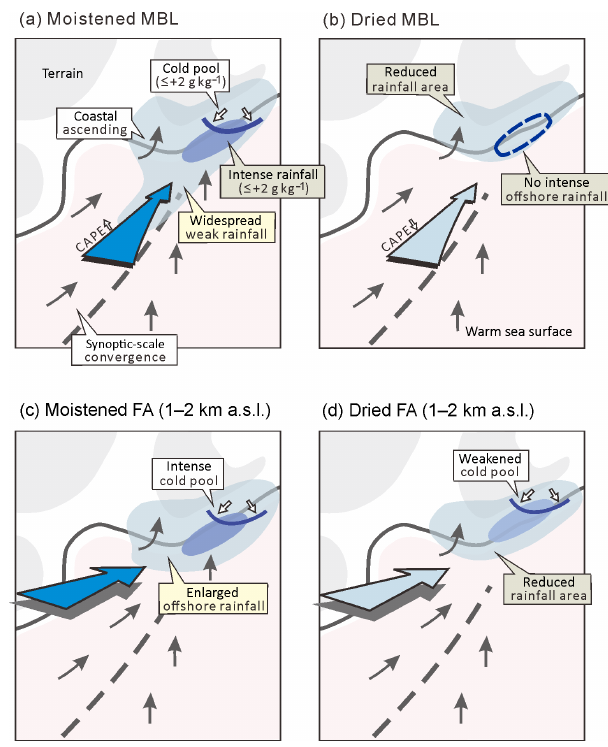
Figure 17. Schematics summarizing the main features of the im- pact of upstream moisture in MBL in panels (a) and (b) , and in the free atmosphere (FA) layer between 1 and 2kma.s.l. in pan- els (c) and (d) on back-building heavy precipitation in south-eastern France during HyMeX IOP13. Dark blue arrows in panels (a) and (c) and light blue arrows in panels (b) and (d) indicate the moist- ened and dried upstream air masses, respectively. In panels (a) – (d) , black arrows and a broken line indicate the low-level wind and the synoptic-scale wind convergence line, respectively. The light blue region depicts the weak precipitation area, while the dark blue re- gion shows the intense precipitation area. The blue solid line illus- trates the southern edge of cold pool, while the closed area with blue dashed line in panels (b) and (d) indicates the absence of in- tense offshore